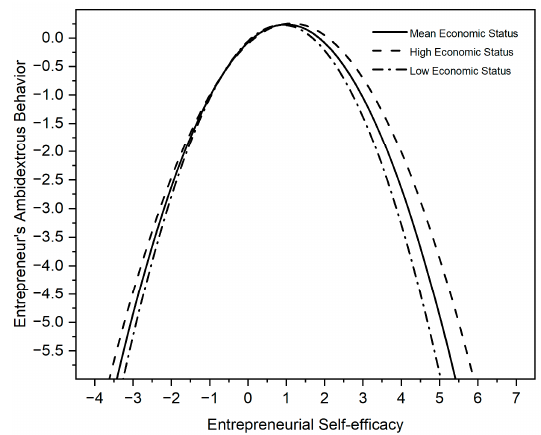
Figure 2. Moderating effects of economic status on self-efficacy and entrepreneurs’ ambidextrous behaviour.